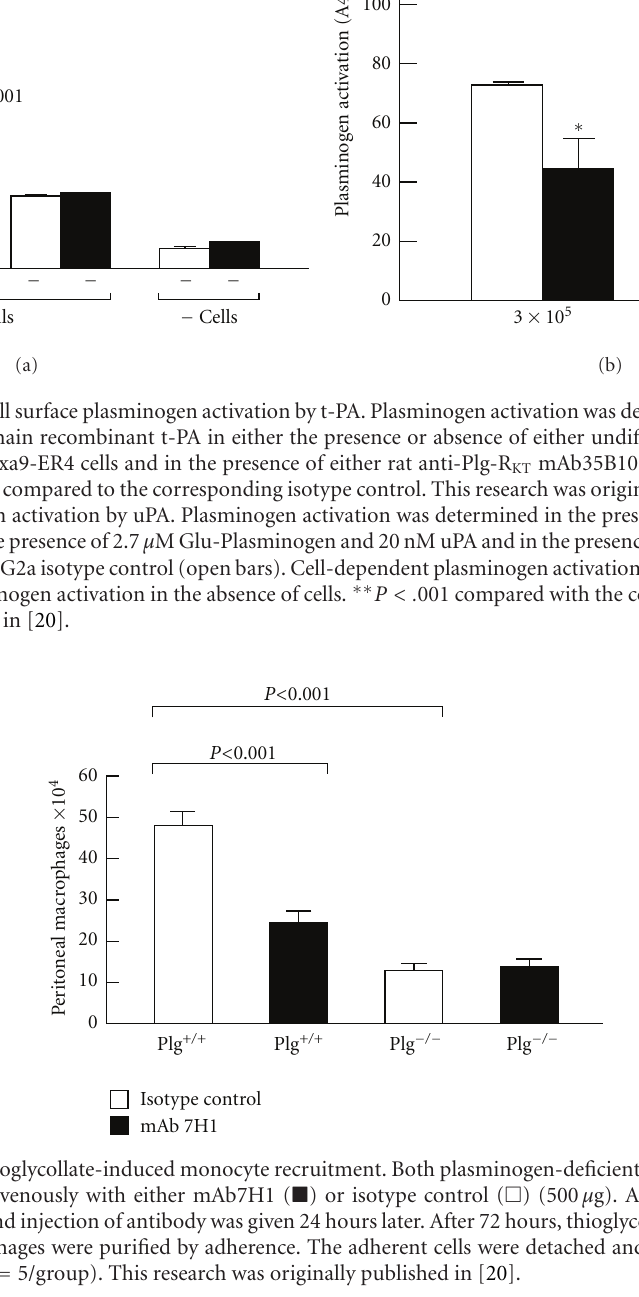
53 ± 4% reduction in peritoneal macrophages, compared to mice injected with the isotype